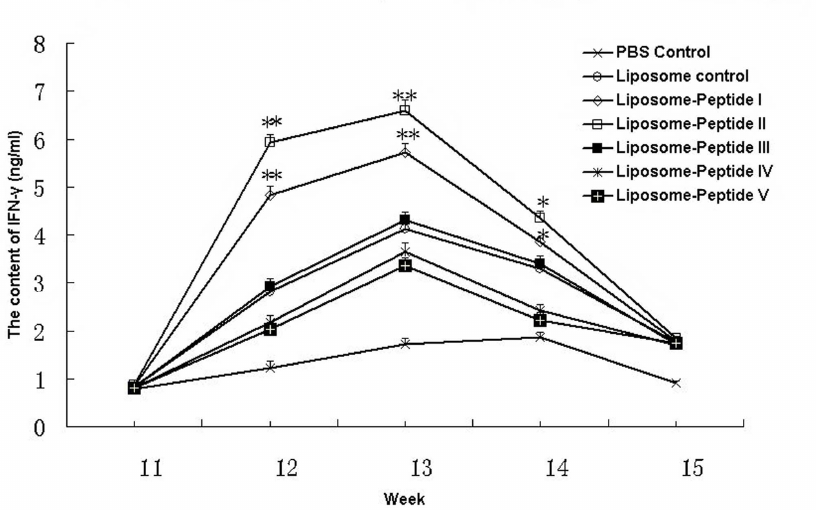
Figure 3. ELISA results for IFN- c release in PBMCs from different groups of mice. IFN- c release in PBMCs stimulated with peptides from different groups of mice was detected after boost immunization at 11, 12, 13, 14 and 15 weeks. Peptides I and II induced a significant increase in IFN- c from 12 to 14 weeks after booster immunization compared to the liposome control, whereas peptide III showed no any significance in IFN- c release increase compared to mice in liposome control group from 11 to 15 weeks. Unrelated peptide IV and peptide V showed a lower IFN- c release level compared to liposome control group from 11 to 15 weeks. ** P , 0.01, * P , 0.05 vs. Liposome control.